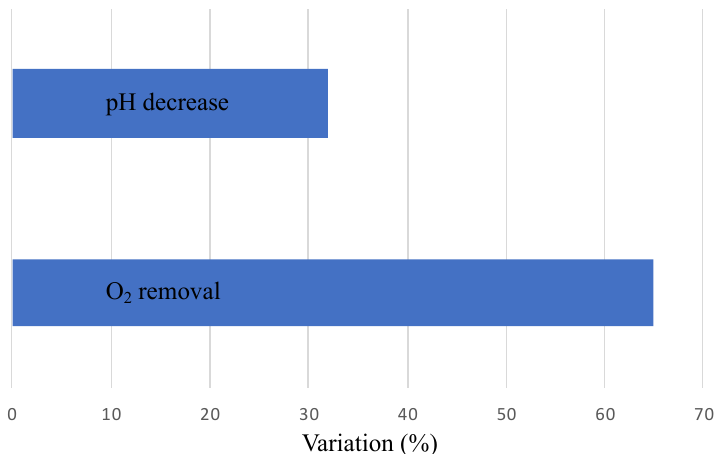
Figure 7. Maximum variations registered in [23] for the seawater pre-treatment.